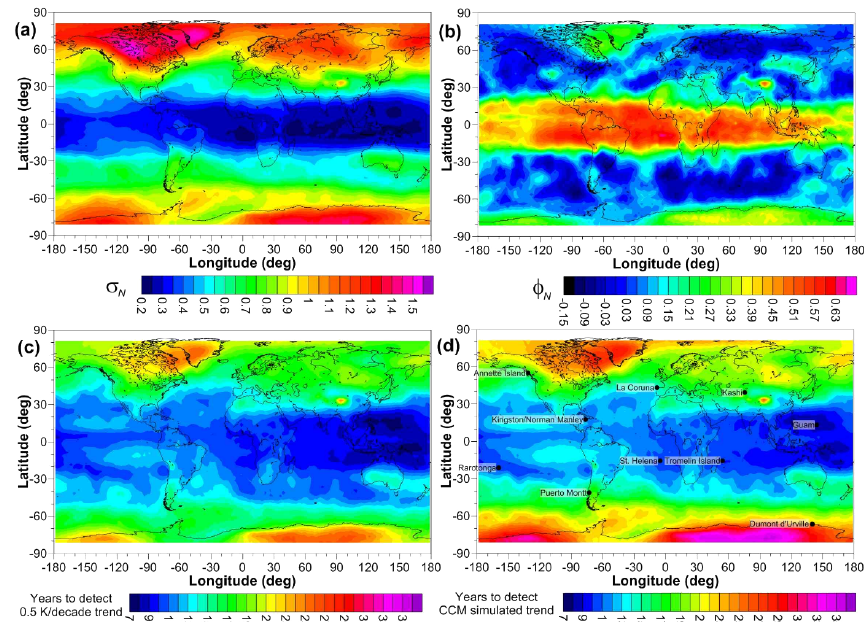
Figure 8. Analyses of merged MSU channel 2 and AMSU channel 5 temperature data – 1978 to 2013. (a) Standard deviation of regres- sion model residuals, (b) the first-order autocorrelation coefficient of the residuals, (c) the number of years required to detect a trend of 0.5Kdecade − 1 , and (d) the number of years required to detect the trend at 5km altitude (close to where the MSU channel 2 and AMSU channel 5 weighting functions peak) as shown in Fig. 6. Only existing GUAN and GRUAN stations have been used as a basis to select the optimal sites for early trend detection shown here.